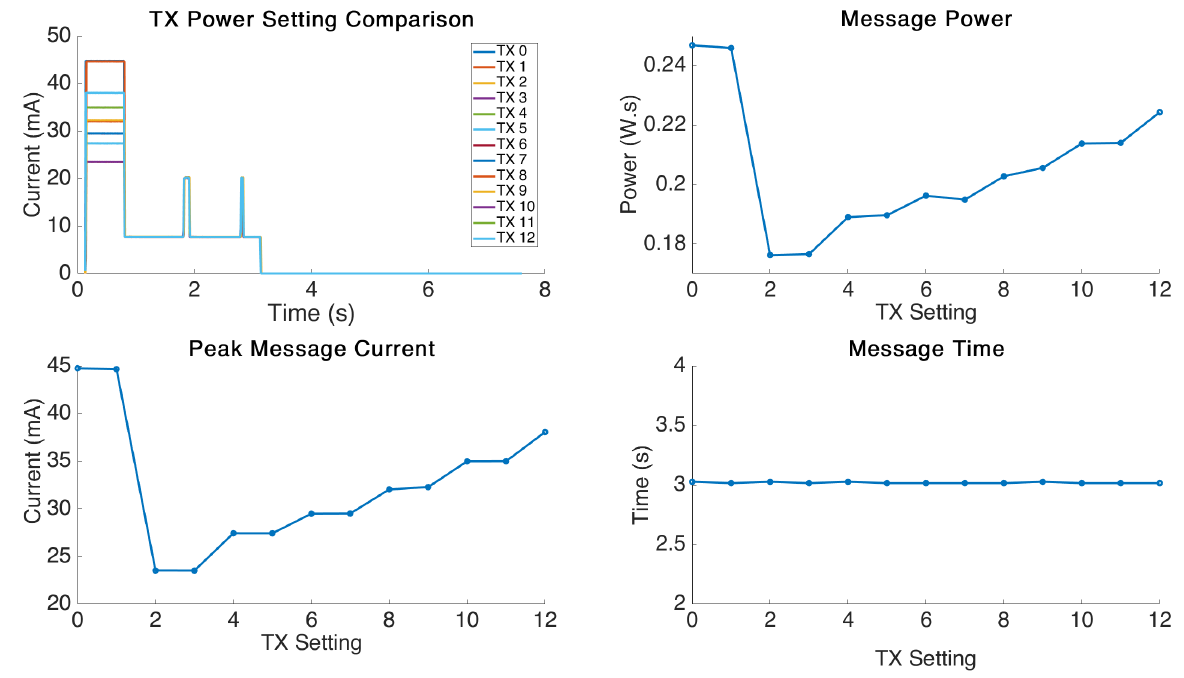
Figure 7. TX power